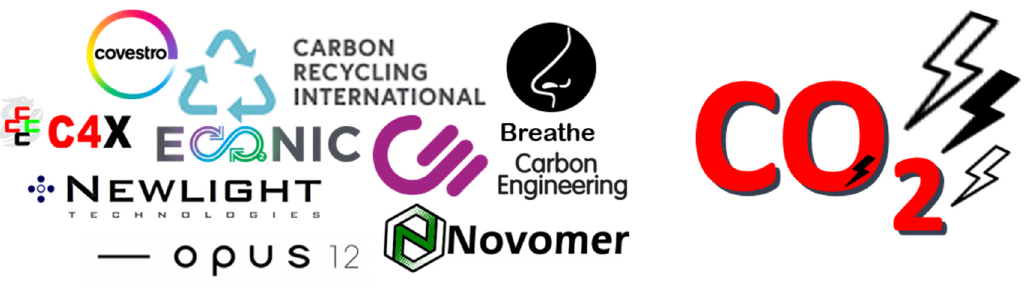
Figure 29. Most active companies developing technologies for CO 2 use and chemical recycling.